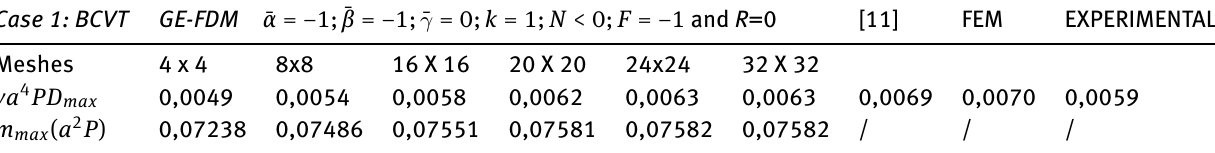
Section two: rectangular plate of variable